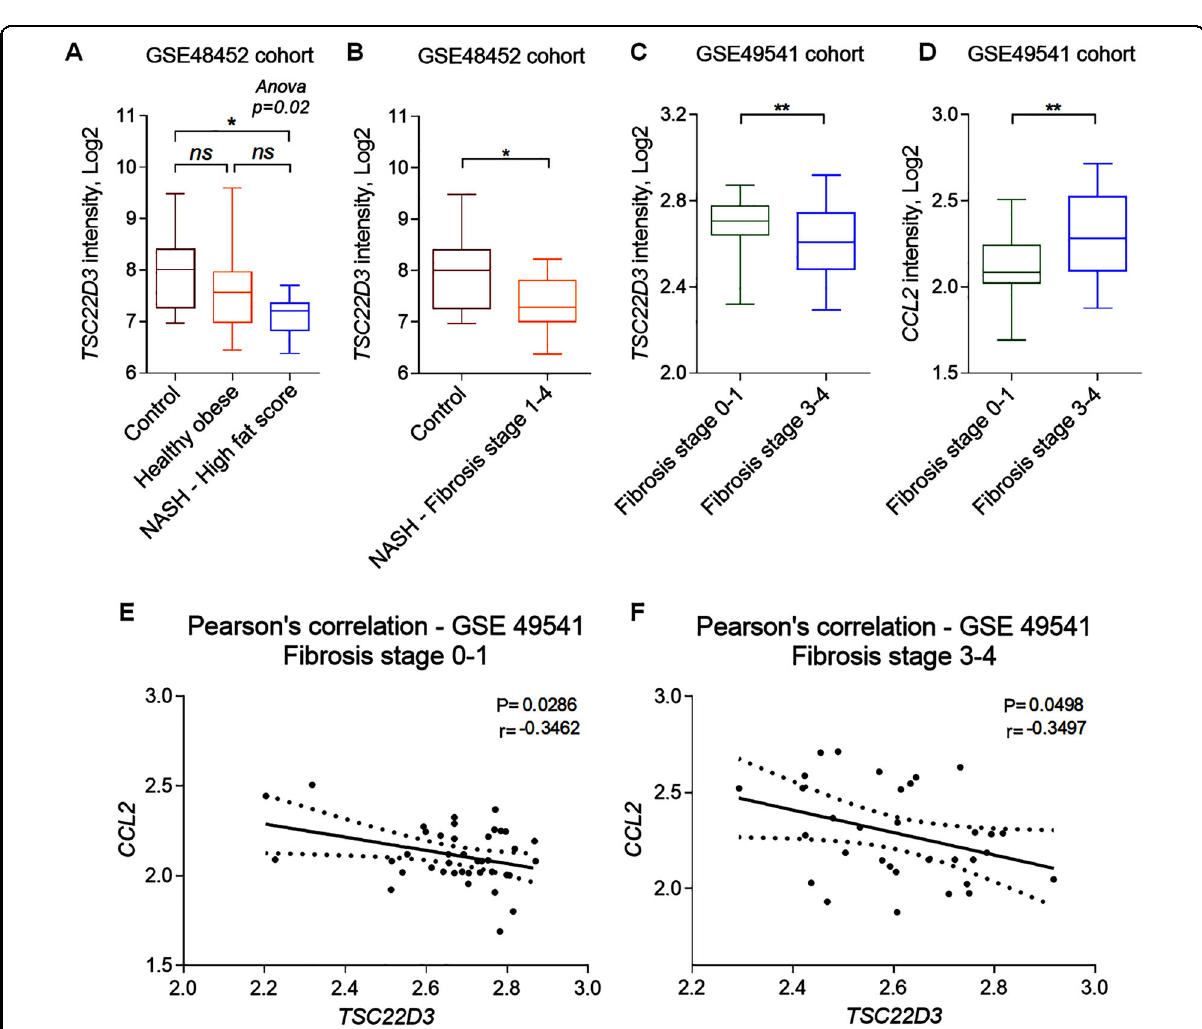
expression in NASH patients. Samples were classi fi ed as A high fat score when presenting a score of ≥ 70 ( n = 9) and B fi brosis stages 1 – 4, representing the samples in this score range ( n = 14). C , D TSC22D3 ( C ) and CCL2 ( D ) gene expression in NAFLD patients with mild (stages 0 – 1; n = 40) and advanced (stages 3 – 4; n = 34) fi brosis. E , F Pearson correlation between TSC22D3 and CCL2 mRNA expression in NAFLD patients. E Pearson correlation coef fi cient in NAFLD patients with mild (stages 0 – 1) and ( F ) advanced (stages 3 – 4) fi brosis. Data are presented as a box and whiskers plot. * p < 0.05, ** p <